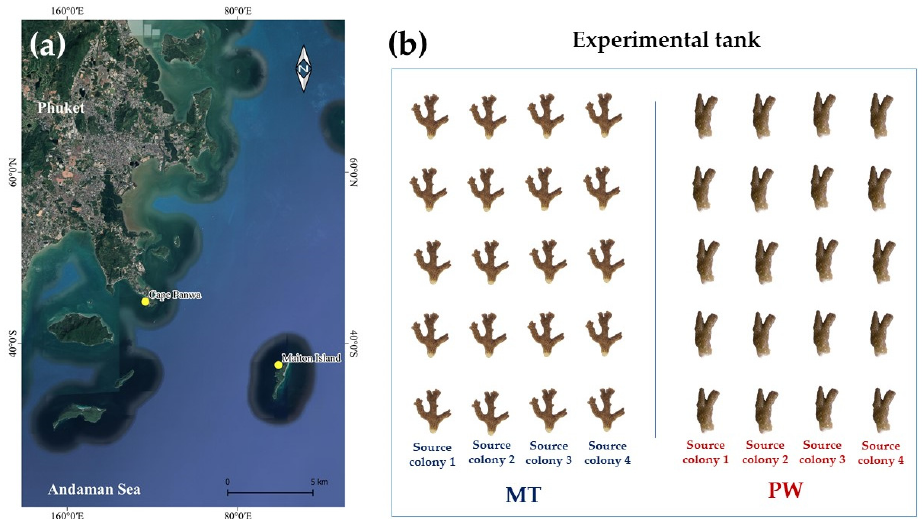
Figure 1. Sampling site locations ( a ), and ( b ) coral nubbins in each experimental tank (20 nub- bins/study site/tank) originally from Maiton Island (MT) and Panwa Cape (PW). Table 1. Environmental parameters of the reef sampled from 5–6 July 2018. Data are given as mean ± SE. Environmental